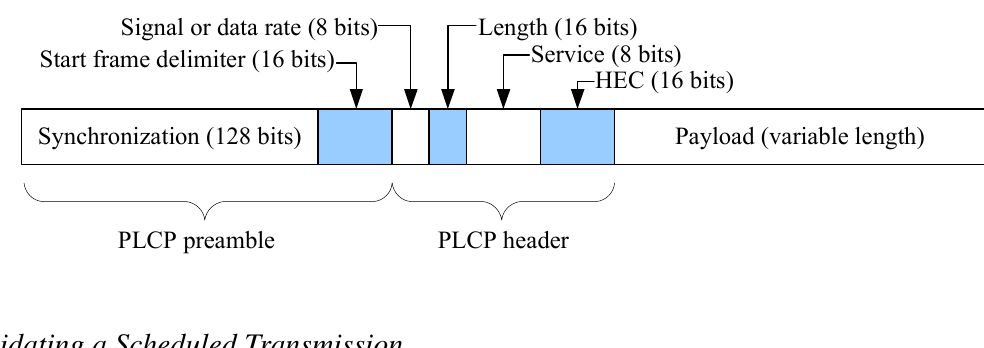
Figure 3. The IEEE 802.11 PHY frame structure when DSSS is used in